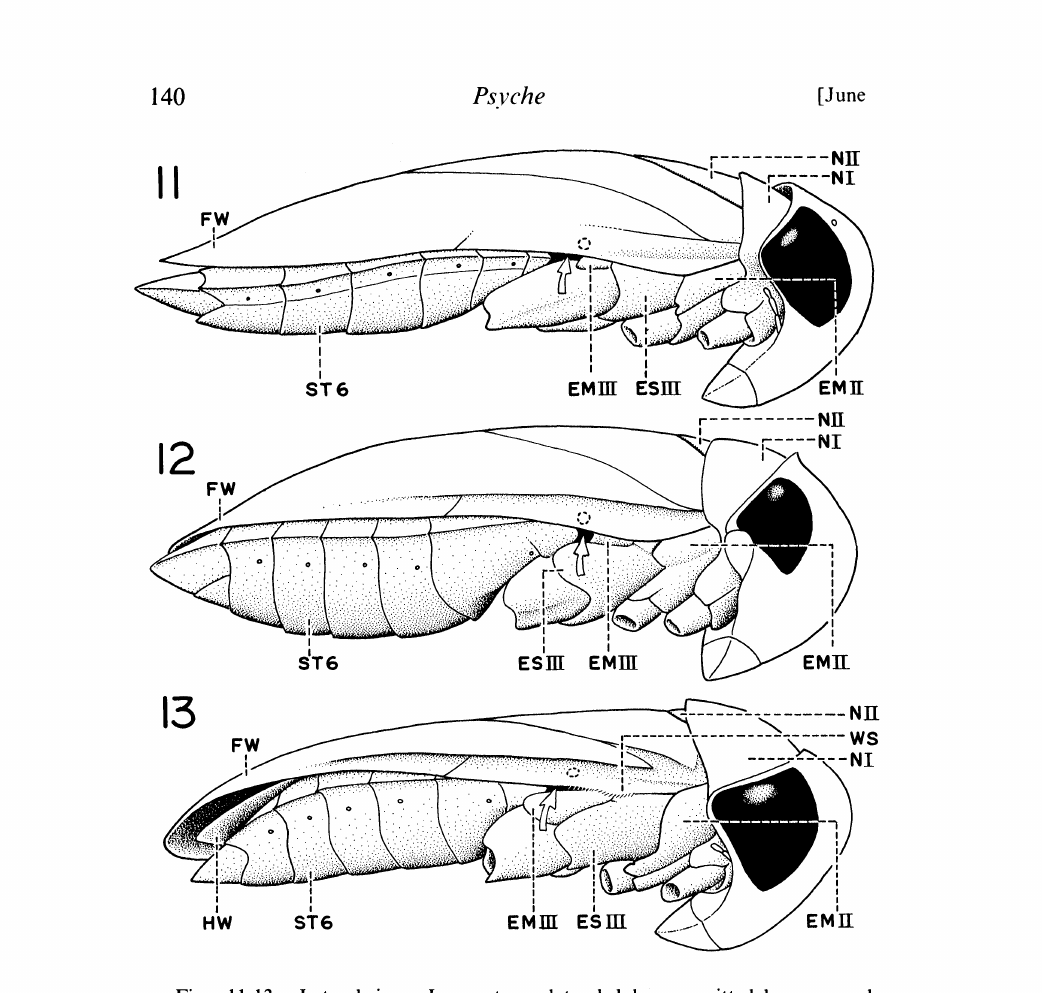
Figs. 11-13. Lateral views. Long setae on lateral abdomen omitted; legs removed distal to coxae. Arrow indicates gap through which ventral air store communicates with subalar air store, which contains too, aouomlnal spiracle (brolcen crcle). Fig 11. D. zealandiae. Fig. 12. M. sedula. Fig. 13. H.